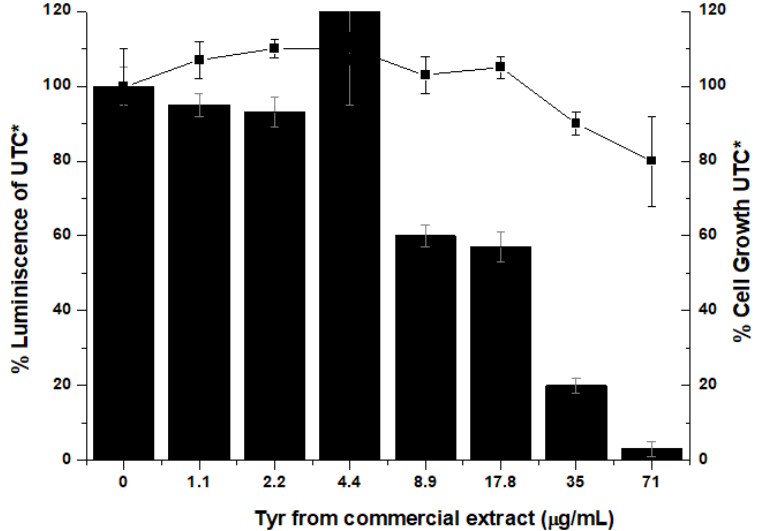
Figure 3. Inhibition of the hepatitis C virus (HCV) replicon in cell assays. Evaluation of the potency and cytotoxicity of the protein in cell (Huh-5-2) assays. HCV replicon replication rate (luminescence, black bars) and cell survival (closed squares) were independently measured in cell culture by increasing protein concentration to determine EC 50 . * All luminescence and viability values were normalized considering the untreated control values (UTC).